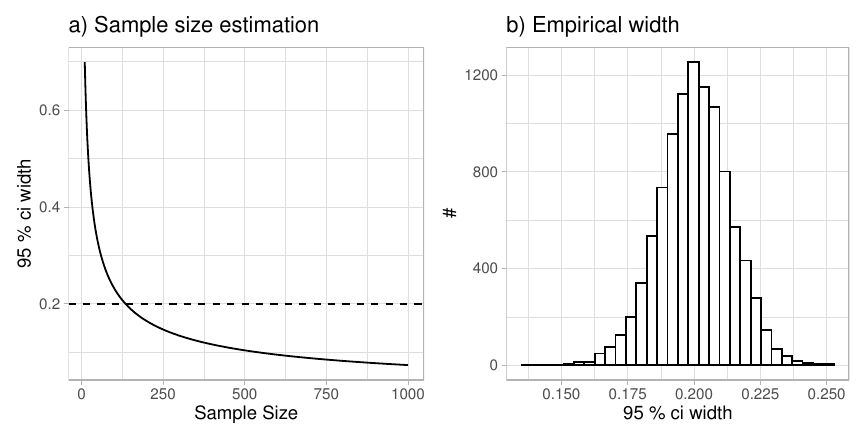
Figure 4 – Sample size estimation for a given confidence interval width under type I censoring (a) and the empirical with of the 95 % confidence interval at 52 weeks based on data from the TOMORROW trial